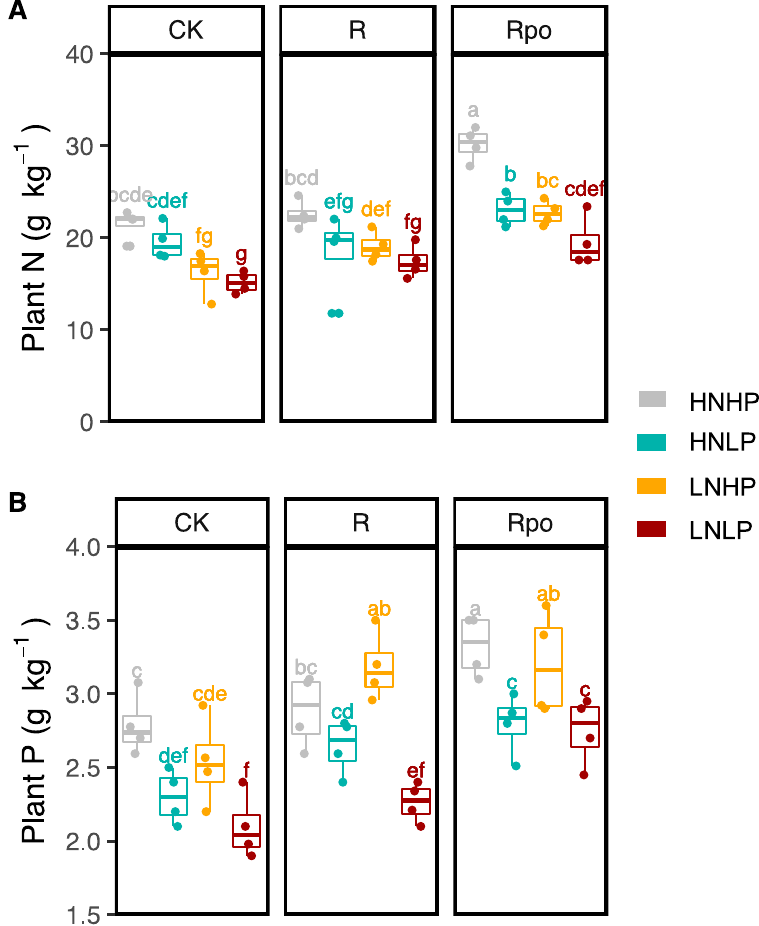
Figure 3. Contents of nitrogen ( A ) and phosphorous ( B ) in soybean plants after exclusive Rhizobium inoculation, and Rhizobium inoculation combined with biochar application under high or low N and P supply. Letters within each column are significantly different at p < 0.05 based on Duncan’s test. No significant differences in N and P uptake were observed for plants grown under HNLP and HNHP supply comparing inoculated and uninoculated plants. Biochar appli- cation significantly increased N and P concentrations in plant tissues under both HNLP and HNHP supplies, compared with uninoculated plants. The N concentration in plants grown under HNLP and HNHP increased, by 25% and 40%, respectively, compared with uninoculated plants (Figure 3A). The P concentration in plants grown under HNHP in- creased by 19%, compared with uninoculated plants (Figure 3B). Shoot biomass, root biomass, and N showed a strong positive correlation with P, and the correlation coefficients were 0.61, 0.61, and 0.58 ( p < 0.05), respectively (Figure 4. Nod- ule numbers showed a significant positive correlation with shoot biomass; the correlation coefficient was 0.57 ( p < 0.05). However, the correlation between nodule number and N was not significant.